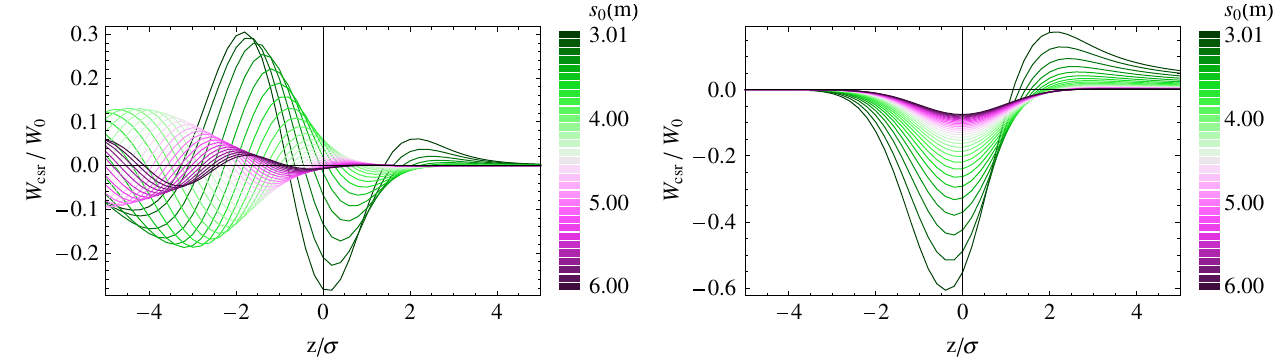
> B FIG. 13. (Color) CSR wakes for various bunch centers s calculated using Eq. (61). The left graph uses parallel plates separated 0 1 by a distance H ¼ 2 cm , while the right graph is for free space [ n ¼ 0 terms only in Eqs. (A6) and (A7), and without Eq. (A5)]. The ¼ 10 m , and the bunch has a Gaussian profile with (cid:10) ¼ 0 : 3 mm and an energy of 1 bending radius (cid:7) (cid:1) 1 1